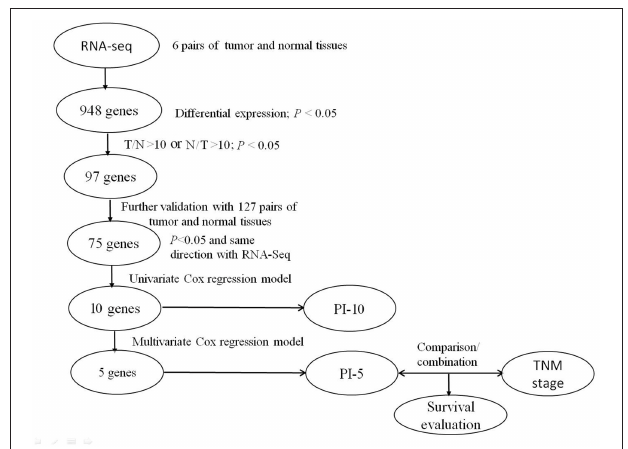
FIGURE 1 | Flowchart of the